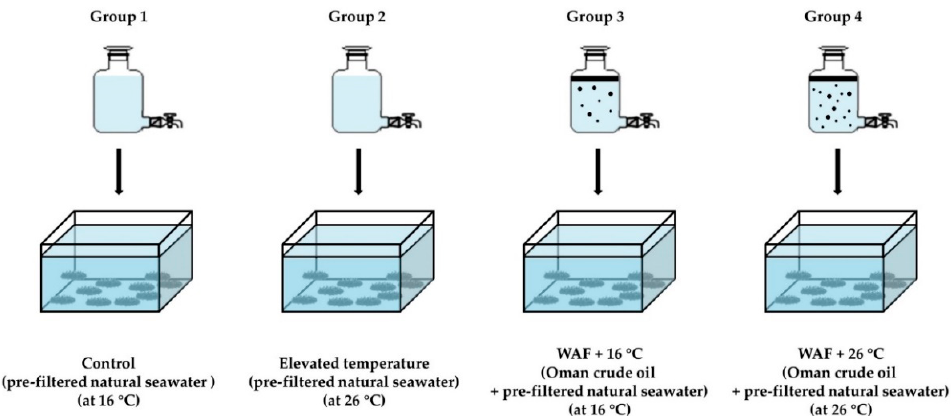
Figure 1. Experimental design of sea cucumber following exposure to elevated temperature (26 ◦ C, Group 2), water- accommodated fractions (WAF) of Oman crude oil at an optimal temperature of 16 ◦ C (WAF + 16 ◦ C, Group 3), and Oman crude oil WAF at an elevated temperature of 26 ◦ C (WAF + 26 ◦ C, Group 4) for 24 h. The Control (Group 1) was the sea cucumber exposed to pre-filtered natural seawater only at an optimal temperature of 16 ◦ C ( n =